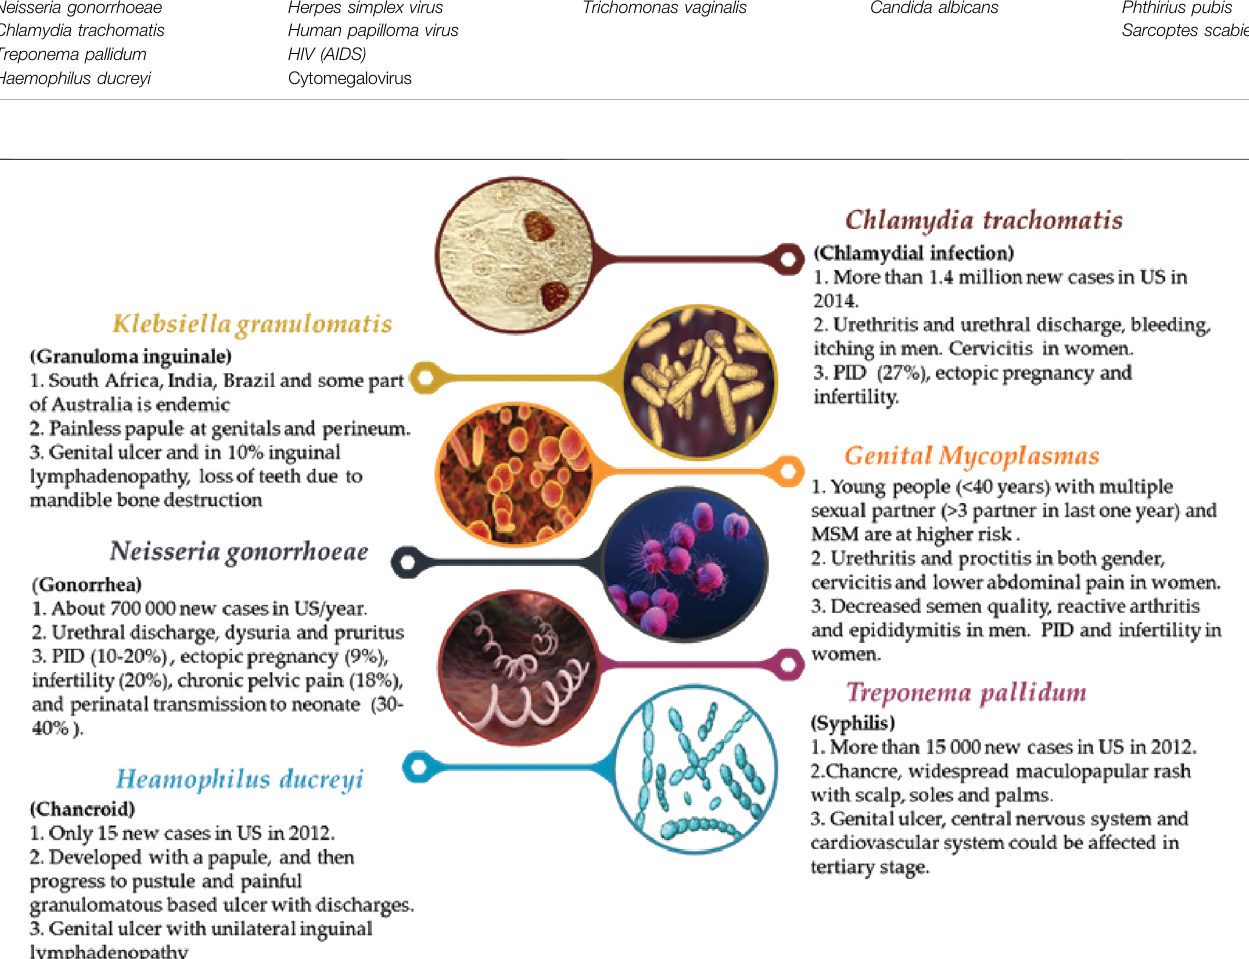
Frontiers in Pharmacology |